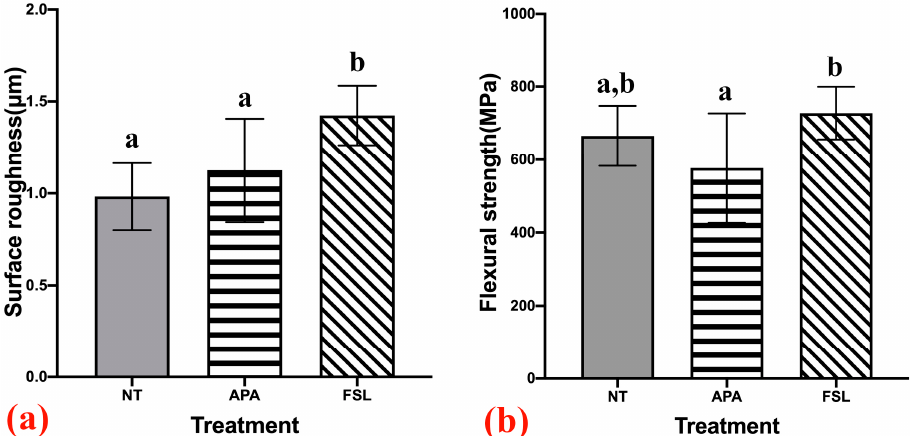
Figure 3. ( a ) The mean surface roughness values (R a ), where the R a value for the FSL group was significantly the highest ( p < 0.05); ( b ) the mean flexural strength values ( p < 0.05), where the result in the FSL group was significantly higher than that in the APA group ( p < 0.05). NT: no treatment